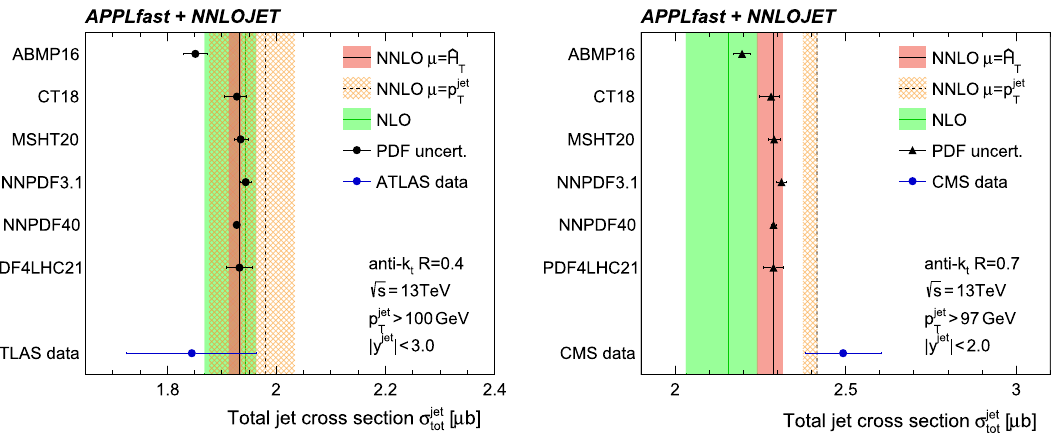
Fig. 8 The PDF dependence of the total jet cross sections for R = 0 . 4 (left) and 0.7 (right) for the fiducial regions defined for ATLAS and CMS, respectively. Uncertainties of a few percent from non-perturbative corrections are not available for the total jet cross